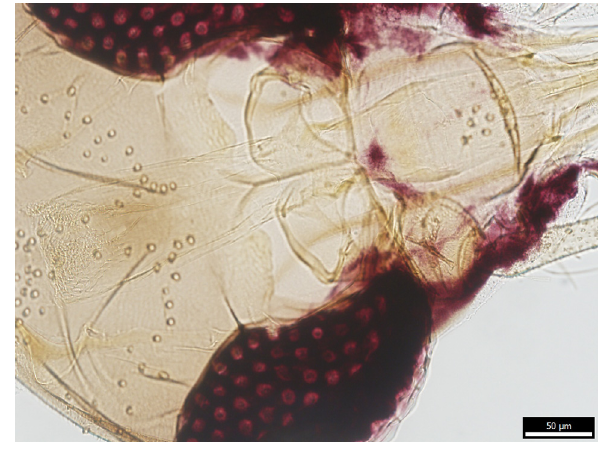
Figure 3. Pharynx of the examined Ph. mascittii specimen with typical pharyngeal armature.